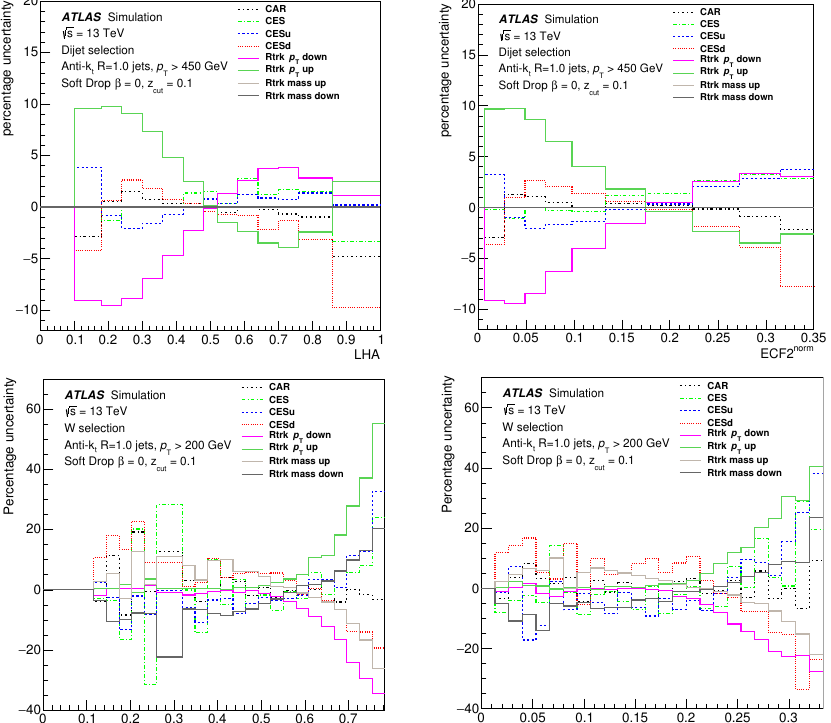
Figure 1 . Bin-by-bin systematic uncertainties due to large-radius jet reconstruction uncertainties associated with cluster, Rtrk and jet mass calibrations in the dijet (top) and W (bottom) selections for the soft-drop groomed Les Houches angularity variable (left) and the normalised ECF2 variable